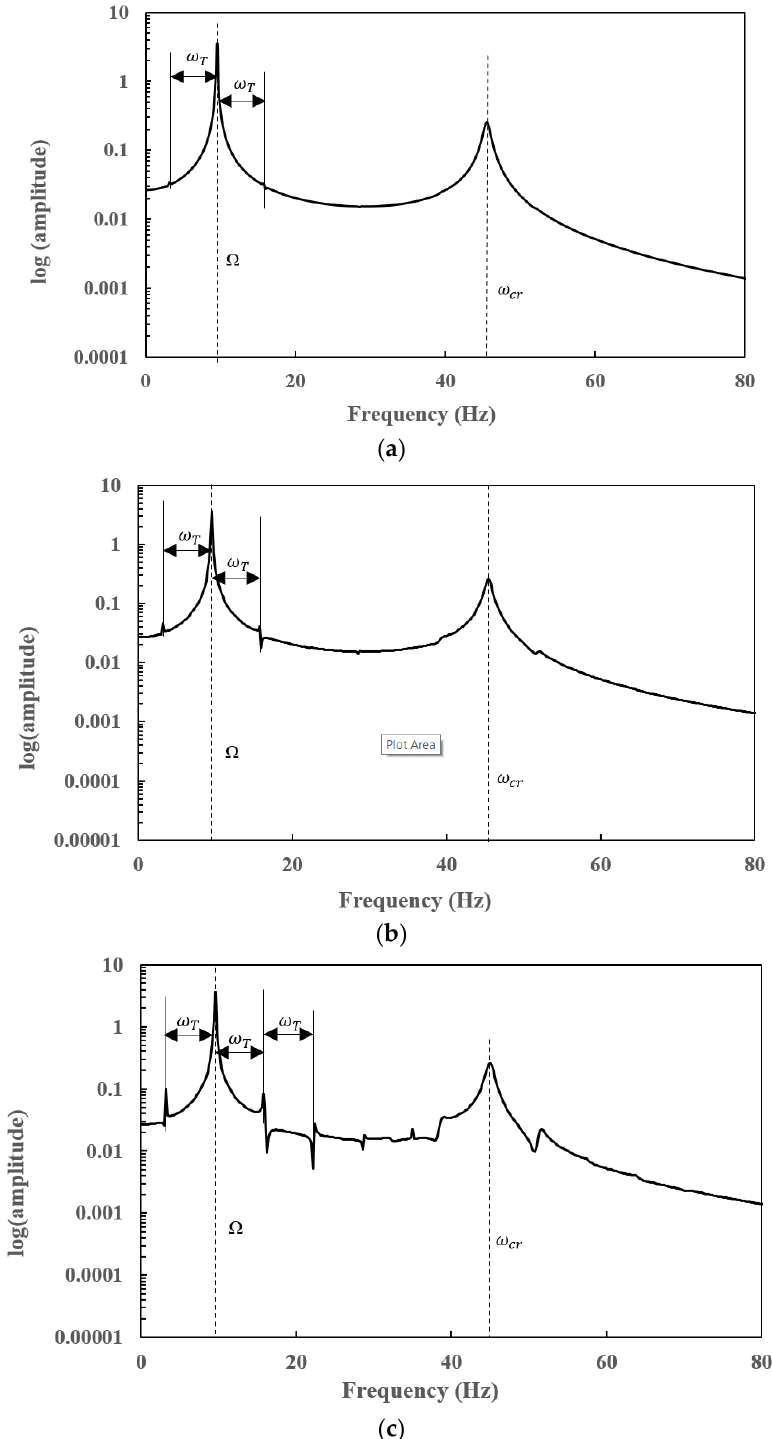
Figure 10. Steady − state FFT of a slant − cracked EG rotor-bearing system with a rotor speed of 60 rad/s, and torsional frequency ( 𝜔 (cid:3021) ) = 40 rad/s for ( a ) 𝛼(cid:3364) = 0.1 ( b ) 𝛼(cid:3364) = 0.2 and ( c ) 𝛼(cid:3364) = 0.4, respec-tively.